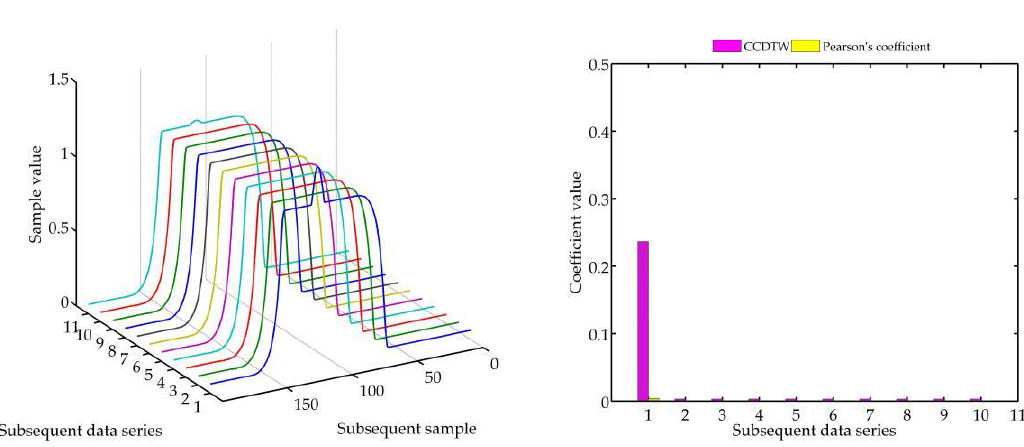
Figure 17. Simulation results achieved for data shifted by − 5 samples for the first series (blue line) for r ampl = 2.